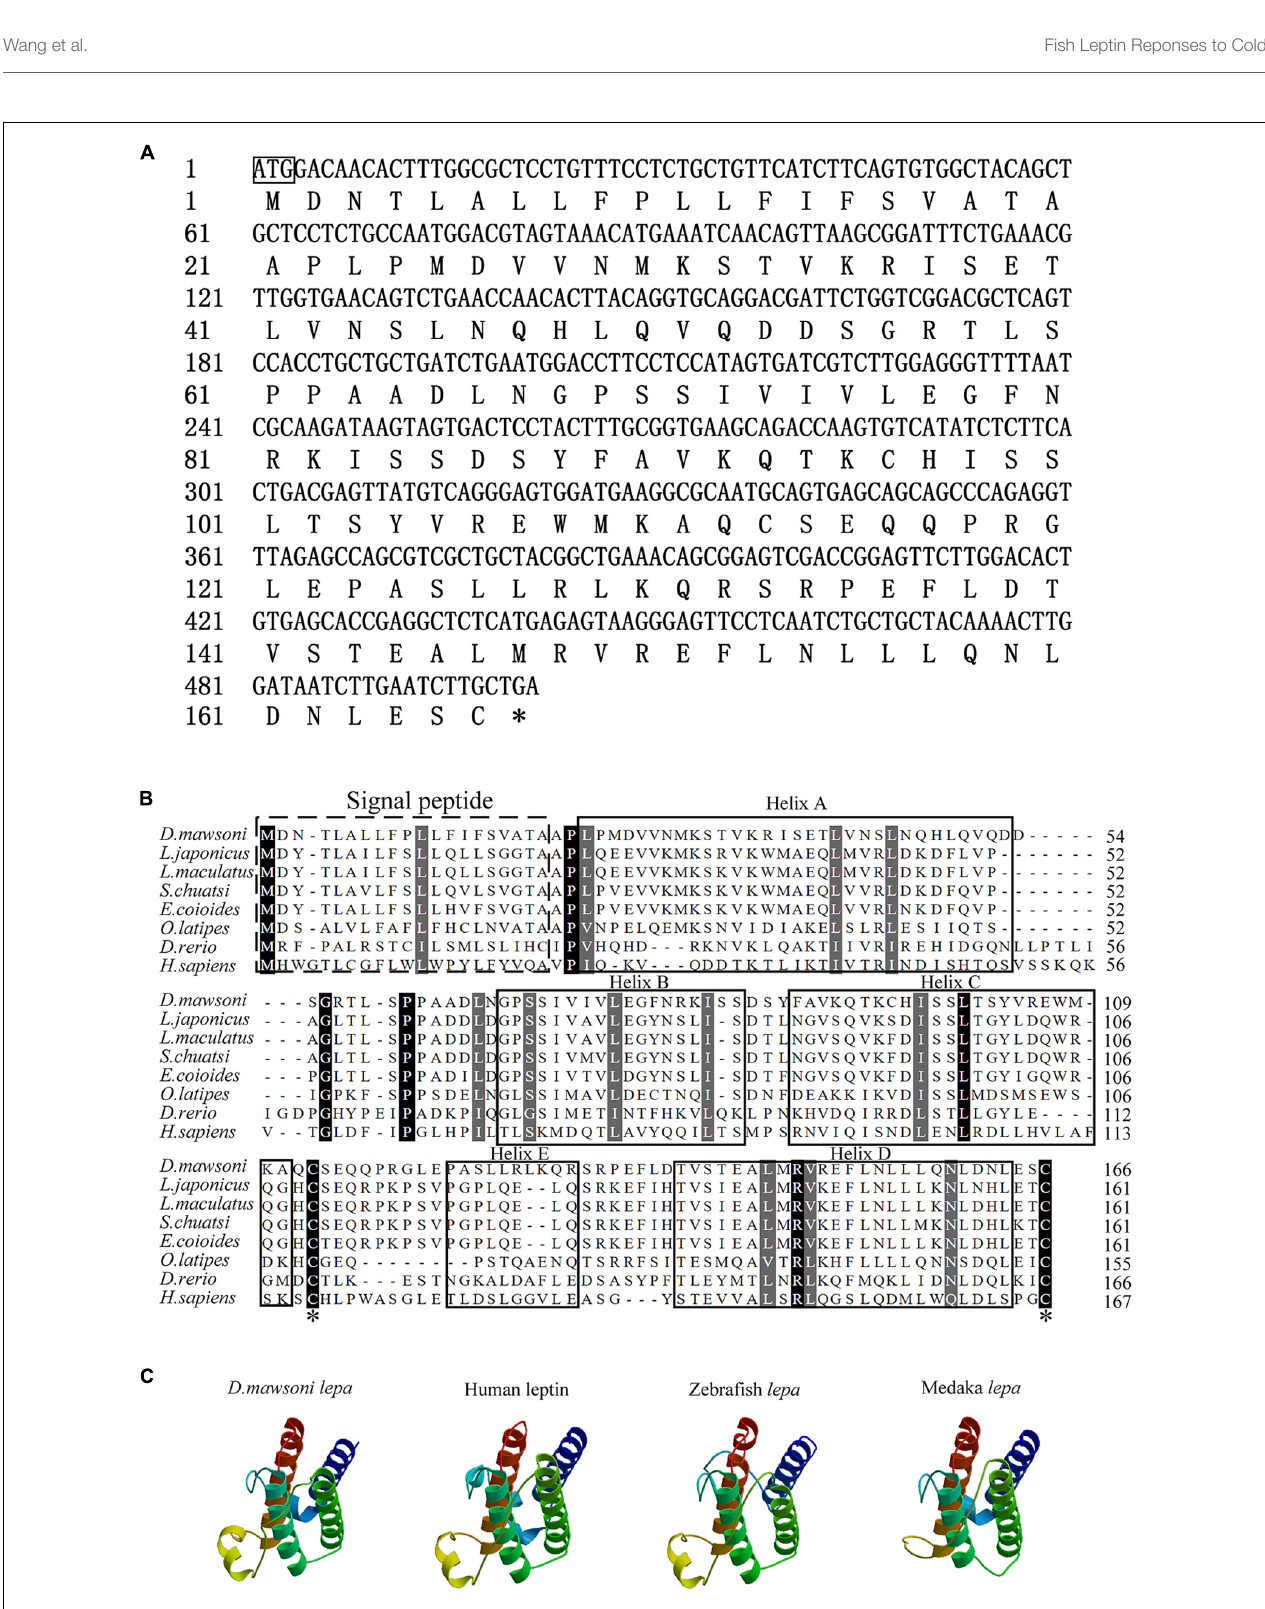
FIGURE 1 | Characterization of D. mawsoni lepa. (A) Coding sequence and encoded amino acid sequence. The box and the asterisk indicates the start codon, the stop codon, respectively. (B) Alignment of leptin-a homologs among the vertebrates. The signal peptide and conserved function domains are indicated with the boxes. Identical amino acid residues are shown in black and the amino acids with > 50% similarity shown in gray. Two asterisks indicate the conserved cysteine residues, which form a single disulfide bridge. (C) Predicted tertiary structure in different species. Four α -helices are displayed in brown, blue, dark green, and green